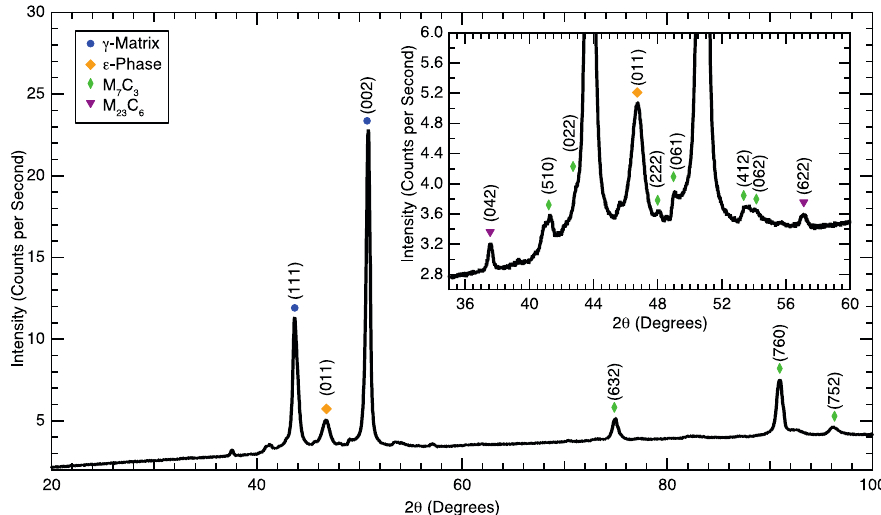
Figure 2. XRD pattern of Co-101 in the as-cast state. The key reflections from the four constituent phases have been identified using TOPAS. An inset is included highlighting the key peaks that can be seen in the range of 35°–60° 2 θ .